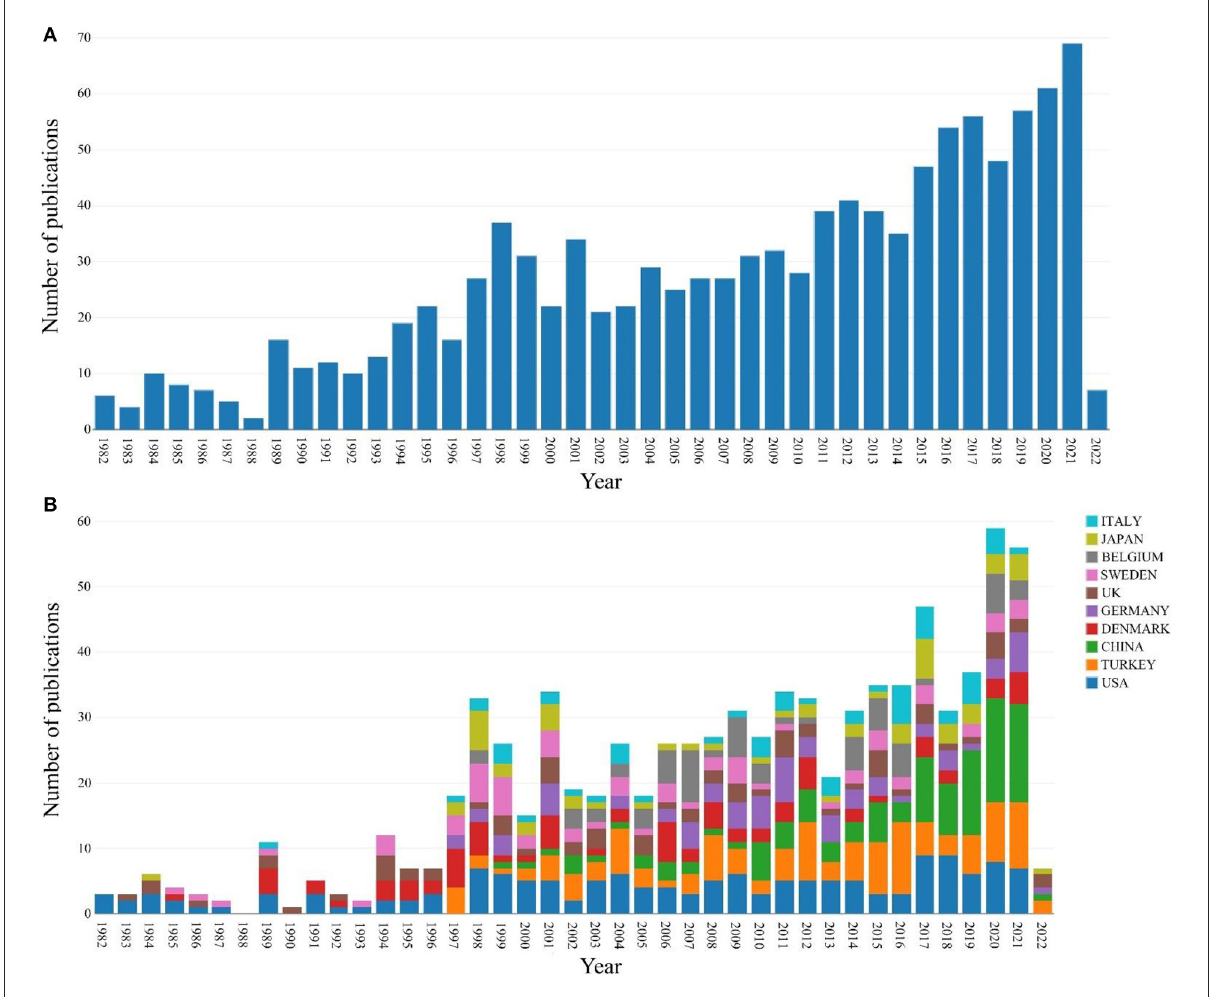
FIGURE2 (A) The number of annual publications on NE from 1982 to 2022. (B) The number of publications per year on NE in different countries from 1982 to